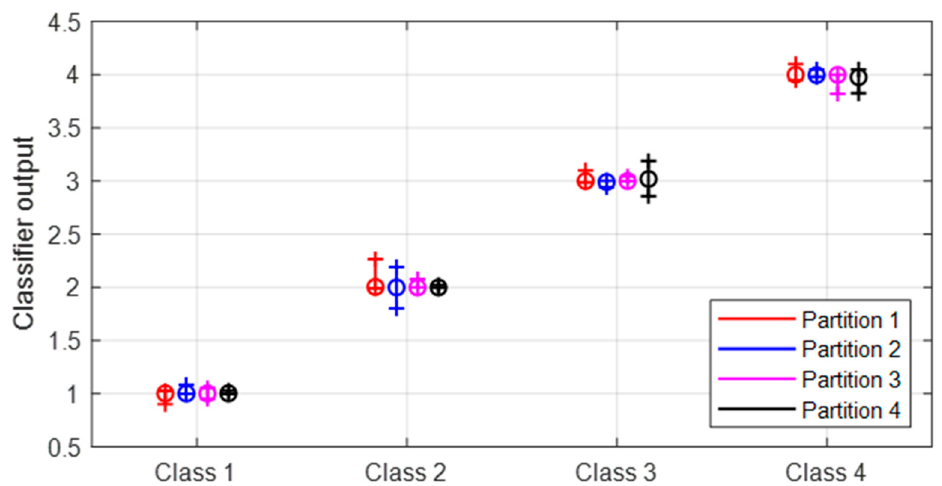
Figure 14. Classification results for different partitions of data into train and test sets. Circles denote